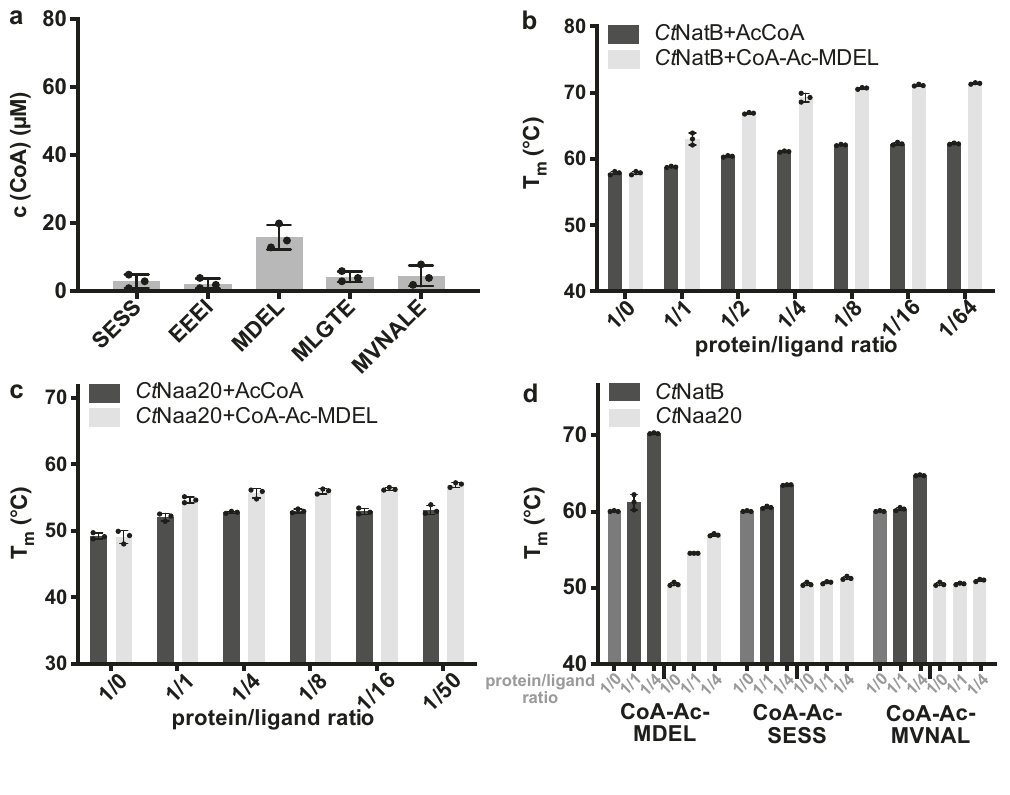
Fig. 3 Ct Naa20 acetylation activity and Ct Naa20/ Ct NatB-ligand interaction. a Substrate speci fi city of Ct Naa20 tested with fi ve different peptides. b Melting temperatures of Ct NatB in the presence of varying concentrations of AcCoA and CoA-Ac-MDEL. c Melting temperatures of Ct Naa20 in the presence of varying concentrations of AcCoA and CoA-Ac-MDEL. d Melting temperatures of Ct NatB and Ct Naa20 in the presence of varying concentrations of CoA-Ac-MDEL, CoA-Ac-SESS, or CoA-Ac-MVNAL. All measurements were performed in triplicates and error bars represent the standard